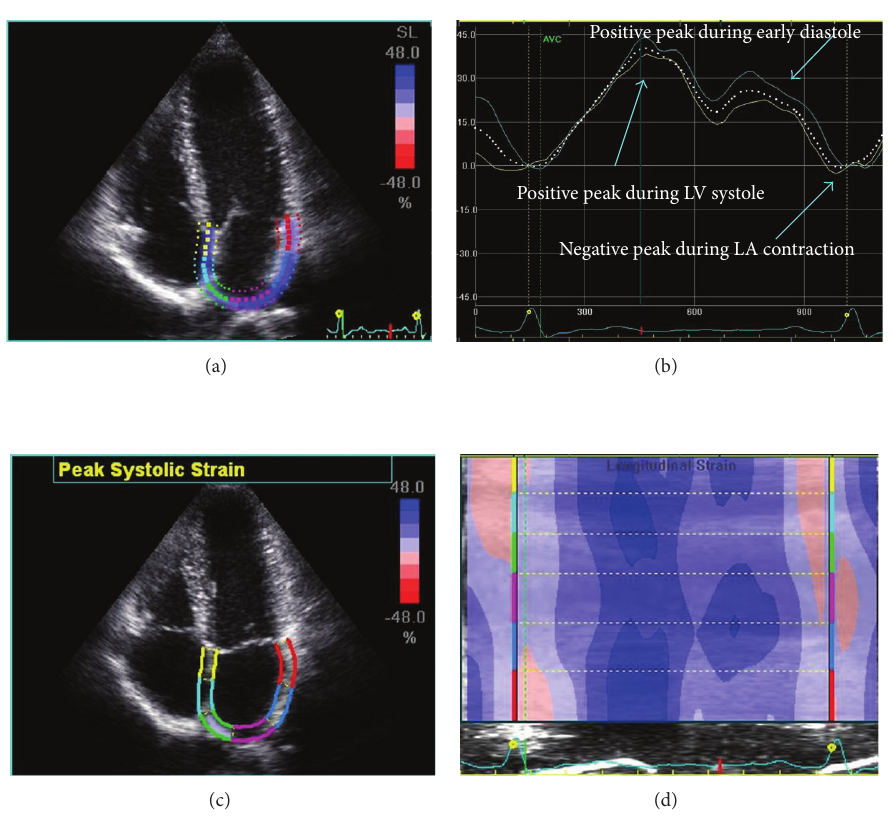
Figure 6: Left atrial deformation (strain) by speckle tracking. During reservoir function, atrial S increases, reaching a positive peak (systolic peak), at the end of atrial filling, before the mitral valve opening, during LV systole. After mitral valve opening, during conduit phase, atrial S decreases, until reaching a plateau, during diastasis, followed by a second positive peak, during early diastole, before LA contraction. Then there is a negative peak, at the end of atrial